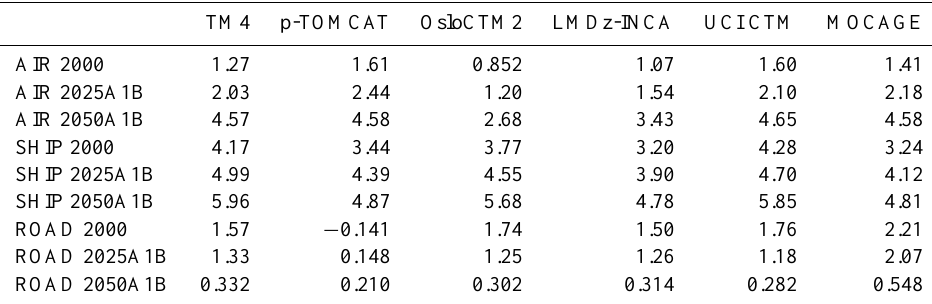
Table A1. Relative changes (%) in methane lifetime (integrated up to 50 hPa) due to a 5% decrease in traffic emissions. Values are global annual averages given relative to the BASE simulation, and are scaled to 100% by multiplying with 20. Note that this table does not include the feedback effect of methane changes on its own lifetime.